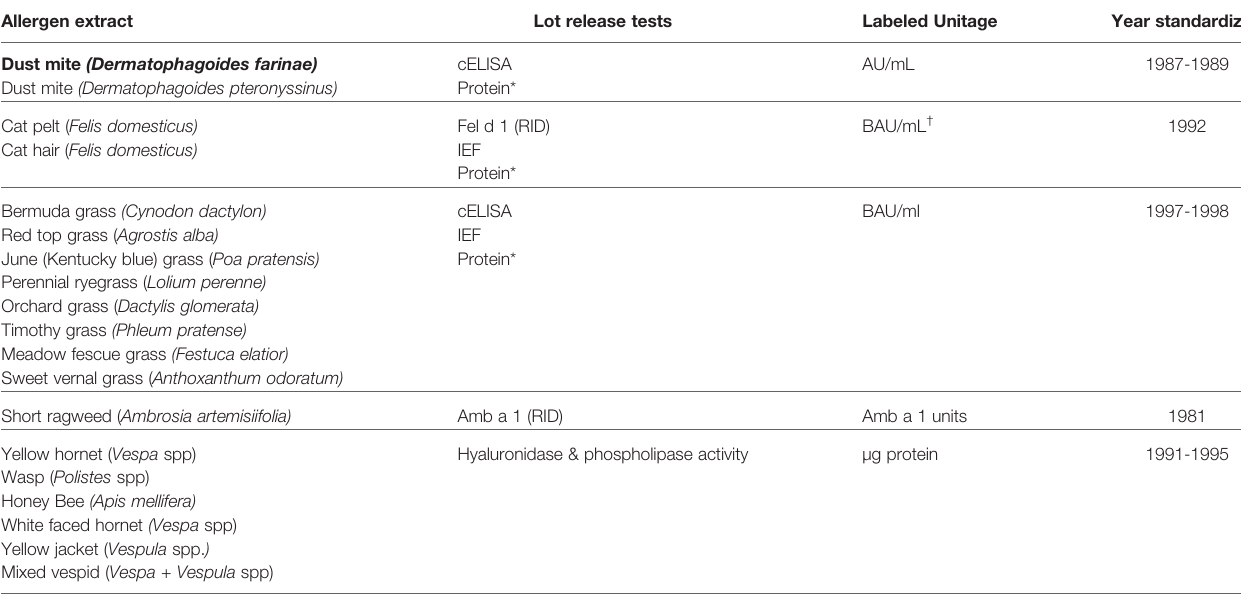
TABLE 3 | Standardized allergen extracts currently licensed in the US. Allergen